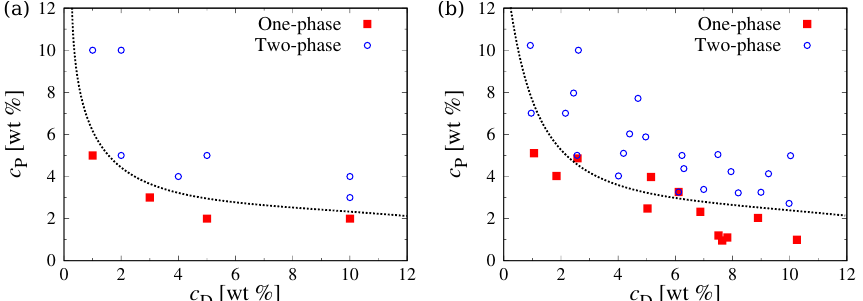
Figure 3. Phase diagram of PEG–Dextran blends in bulk from ( a ) simulations and ( b ) experiments [18]. The dotted lines indicate the estimated binodal. Simulation data are generated from monodisperse systems with M P n = 6kg/mol and M D n = 500kg/mol, while experimental data were gathered for blends with M P w = 6kg/mol and M D w =